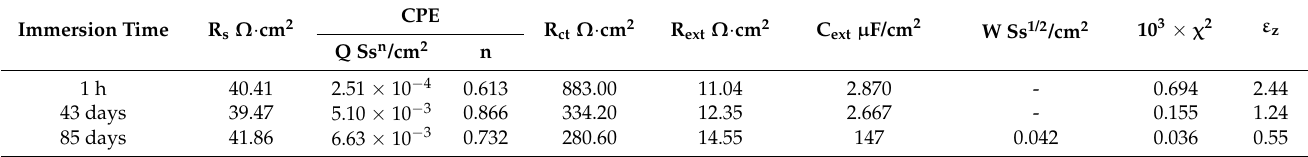
Table 5. Equivalent circuit element values for PS immersed for various periods in BSW. Immersion Time